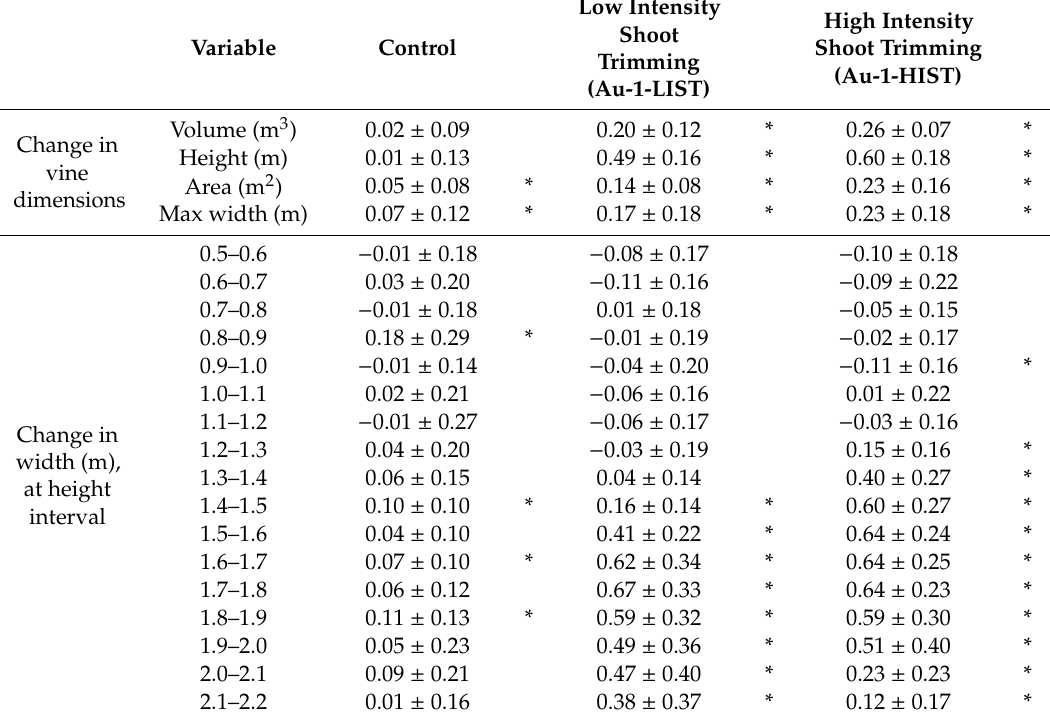
Table 6. Mean and standard deviation of vine dimension changes after low and high intensity shoot trimming experiment at Ausejo-1. The table is divided in two parts: (1) changes in main dimensions of the vine, (2) changes in the width at di ff erent height intervals. Values followed by an asterisk are indicative of significant di ff erences among the vine dimensions before and after the canopy management (paired T -test at p =